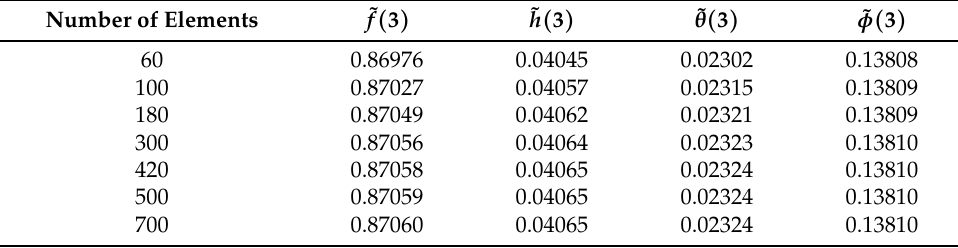
Table 1. FEM convergence results of ˜ f ( ξ ) , ˜ h ( ξ ) , ˜ θ ( ξ ) , and ˜ φ ( ξ ) for a different number of elements when